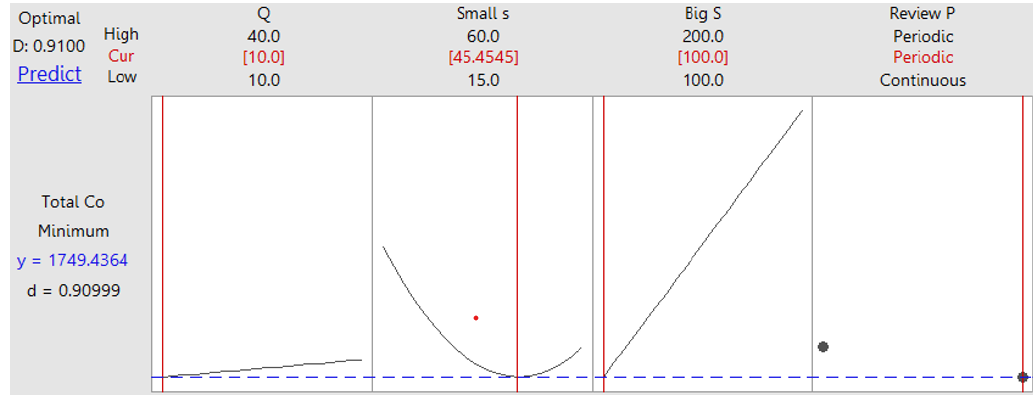
Figure 16. Optimization parameters of Box-Behnken design.